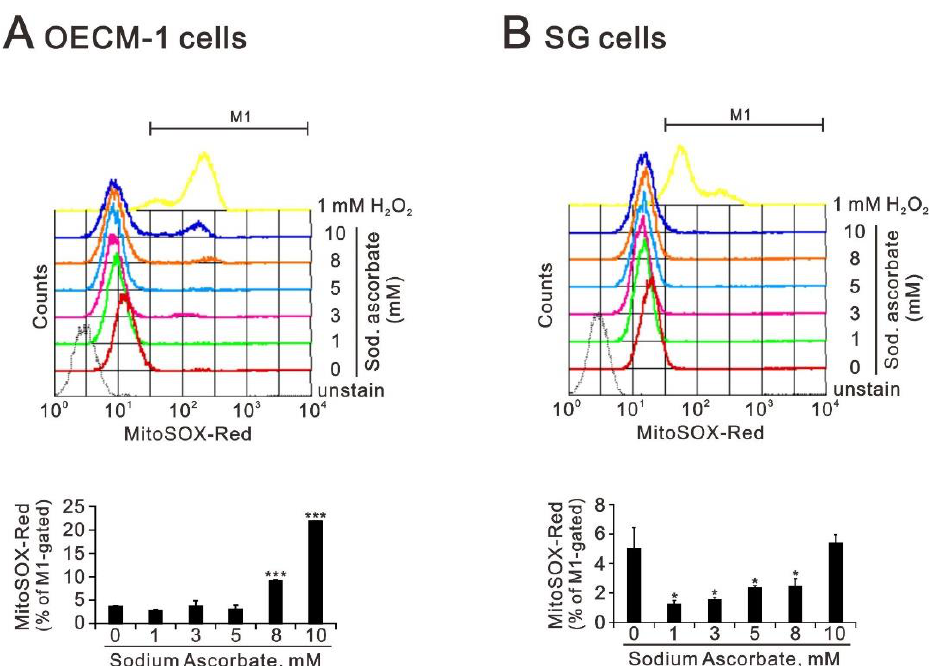
Figure 7. Effects of sodium ascorbate and L-ascorbic acid on the levels of mitochondrial ROS in OECM-1 and SG cells. ( A ) OECM-1 (3.5 × 10 5 ) and ( B ) SG (3.5 × 10 5 ) cells were cultured in 6-well plates and treated with the indicated concentrations of sodium ascorbate for 4 h. They were then subjected to measurement of MitoSox intensity. Bars depict the mean ± SD of three independent experiments. Student’s t -tests were analyzed and compared with vehicle. * p < 0.05 and *** p < 0.001. The increasing trend in subG1 by sodium ascorbate revealed that mitochondrial dys-